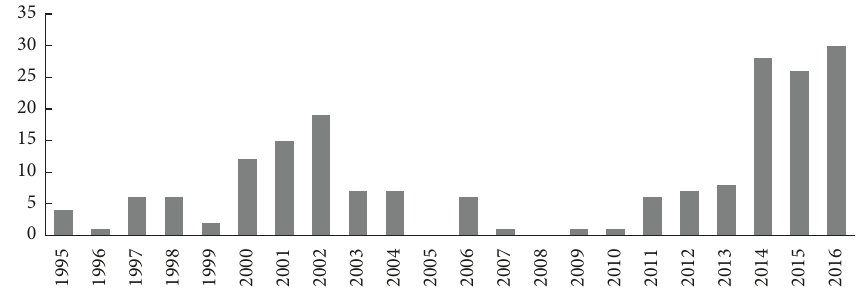
Figure 1: Te number of TCIDs implemented in China from 1995 to